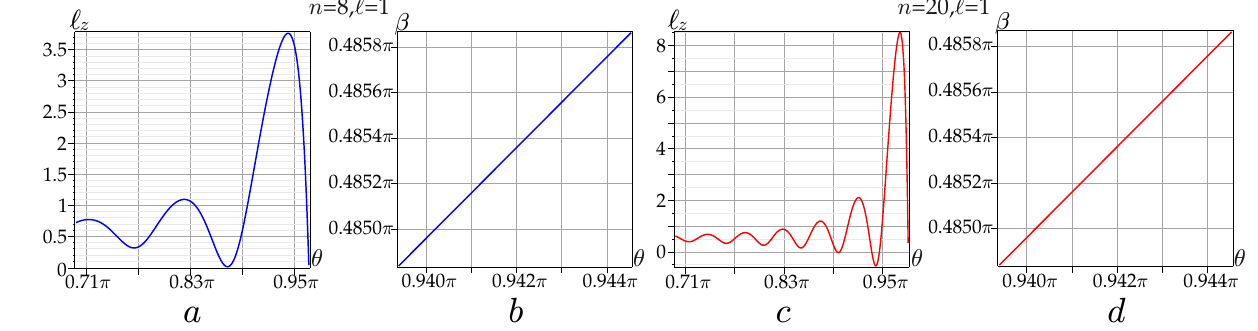
Figure 7. Asymptotic plots of the OAM ( a , c ) for ( (cid:101) , β ) = ( 1, π /4 ) and positions of main maxima ( b , d ) at (cid:101) = 1 in the asLG beams with the indices ( n , (cid:96) ) = ( 8,1 ) ( a , b ) and ( n , (cid:96) ) = ( 20,1 ) ( c , d